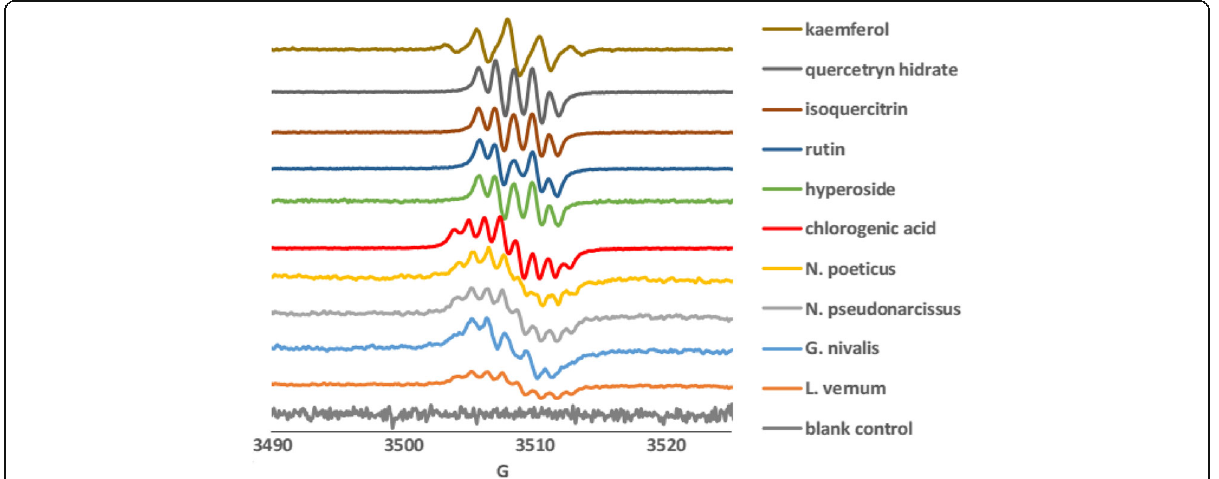
Fig. 8 EPR spectra of Amaryllidaceae species and of references compounds, treated with NaOH, in ethanol 90%. The blank control sample contains only ethanol 90% and NaOH